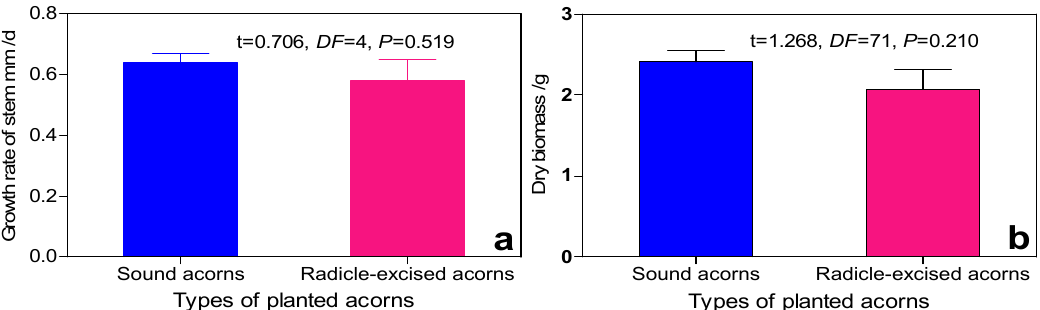
Figure 4. Growth rate of seedling stem ( a ) and dry biomass of seedlings ( b ) from sound acorns and radicle-excised acorns. To reduce the influence of emergence date (e.g., climatic factors) on seedling development, the seedlings emerging at same day were chosen to calculate the growth rate of stalk. So, the available sample was less than the total sample when compared the growth rate of stalk.